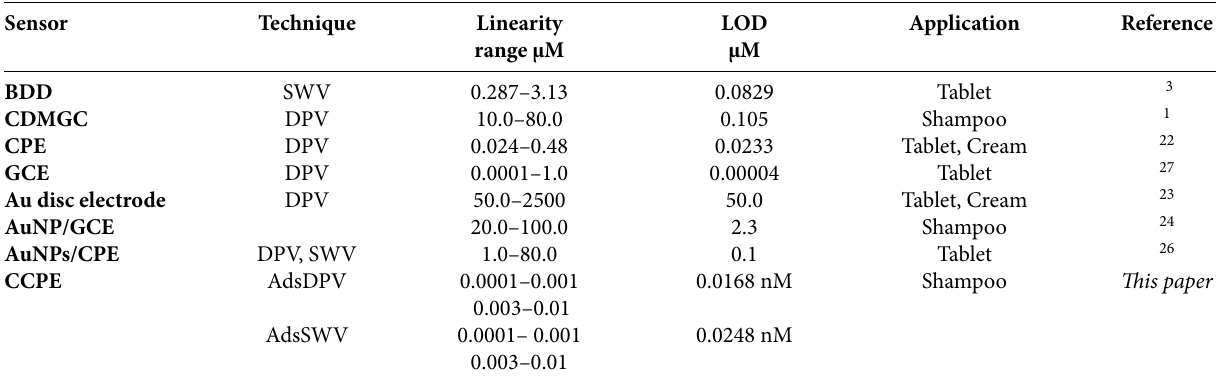
Table 2 . The comparison of analytical data reported by some different electrochemical sensors with the CCPE sensor for KC analysis.